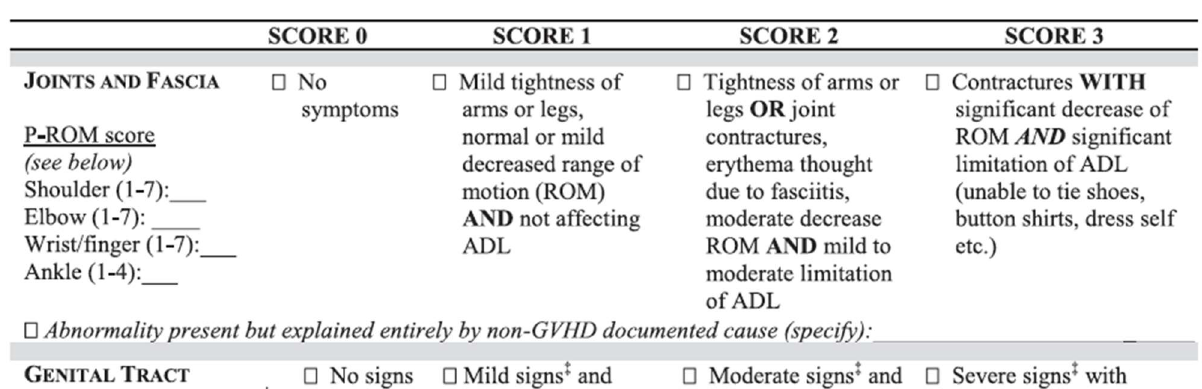
Figure 1 . Section of Scoring Card from NIH Chronic Graft Versus Host Disease Criteria Relevant to Musculoskeletal Manifestations.